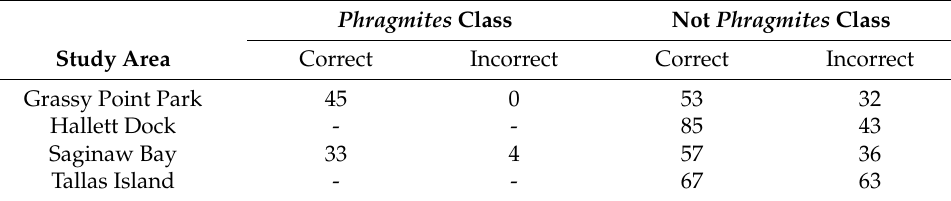
Table 5. Validated assessment points for each study area for the classification using only the RGB UAS imagery. Points are split by class ( Phragmites , Not Phragmites ) and if they were correctly identified (Correct,